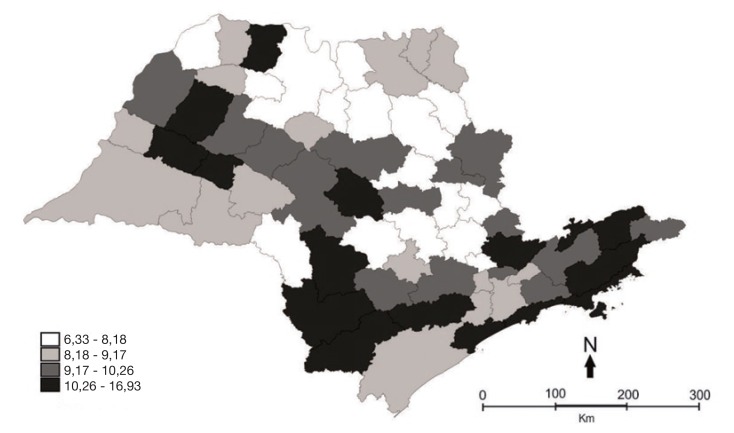
Mapa temático da distribuição das taxas de mortalidade neonatal total,
por 1000 nascidos vivos, segundo microrregiões, São Paulo, 2006-2010